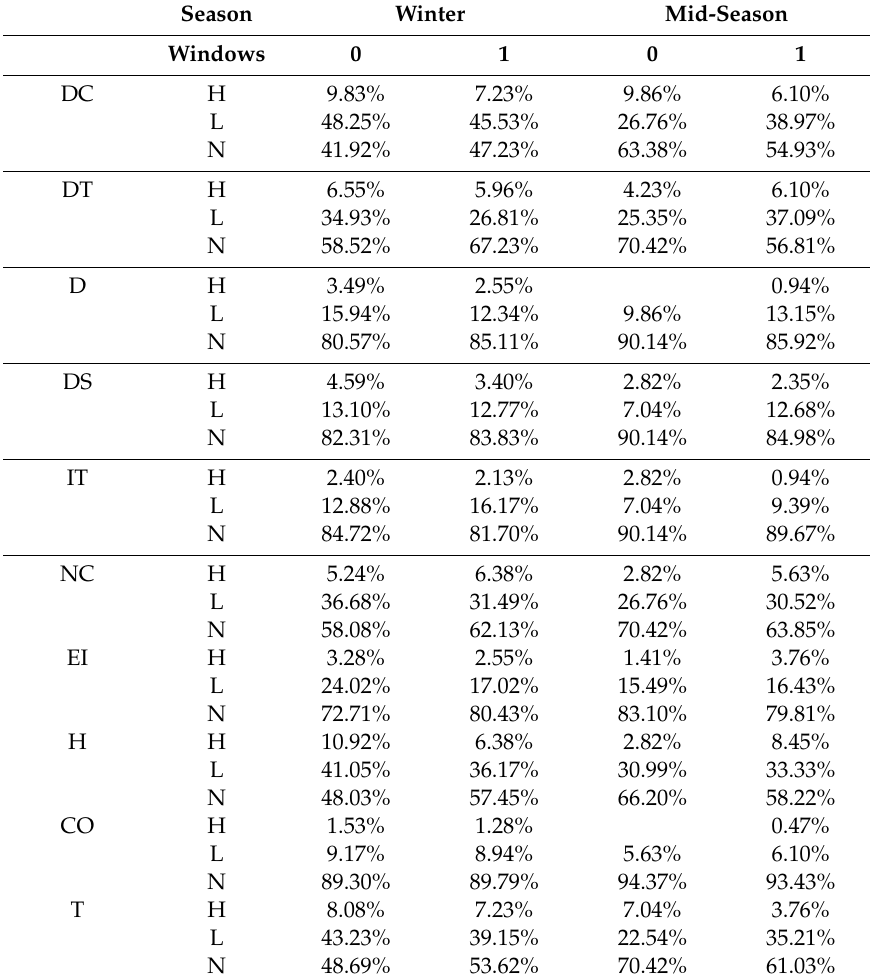
Table 8. Relative probability of occupants’ relating symptoms and health e ff ects, from N (not perceived), to L (lightly perceived), and H (severe perception), with closed windows (0) and open